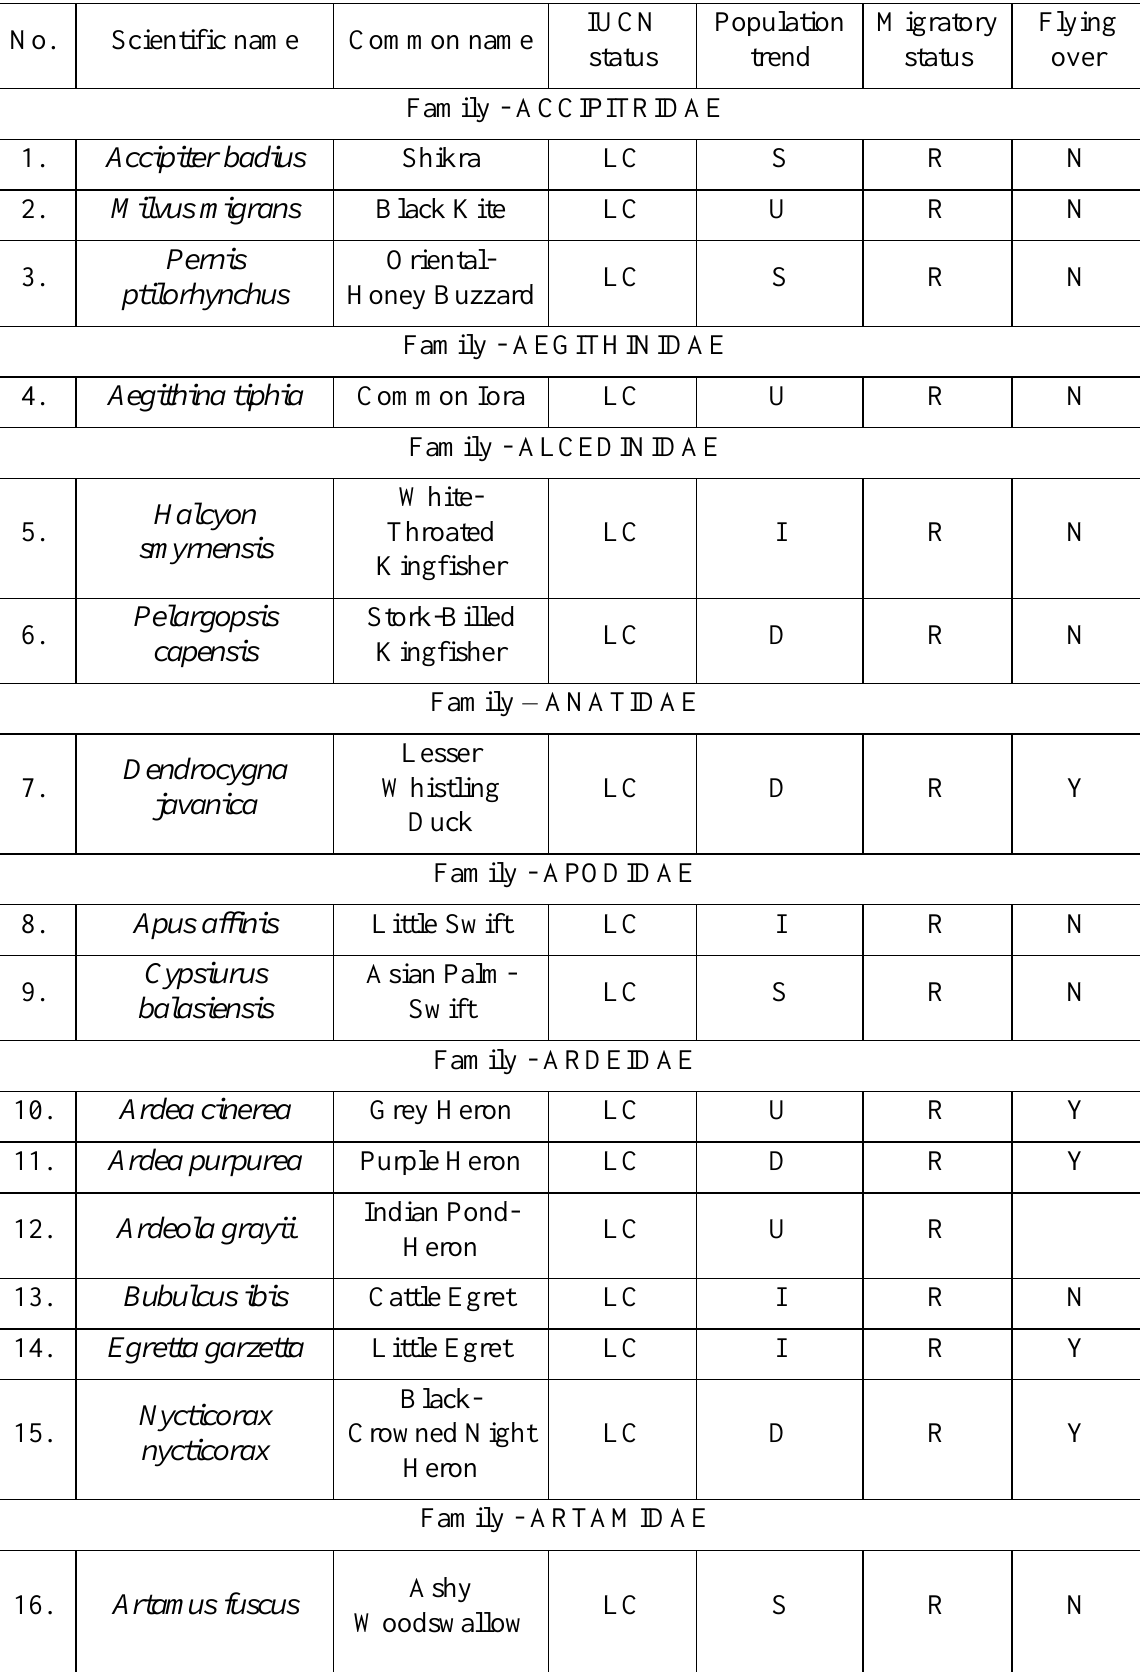
Table 1. List of bird species recorded in Durgapur Government College